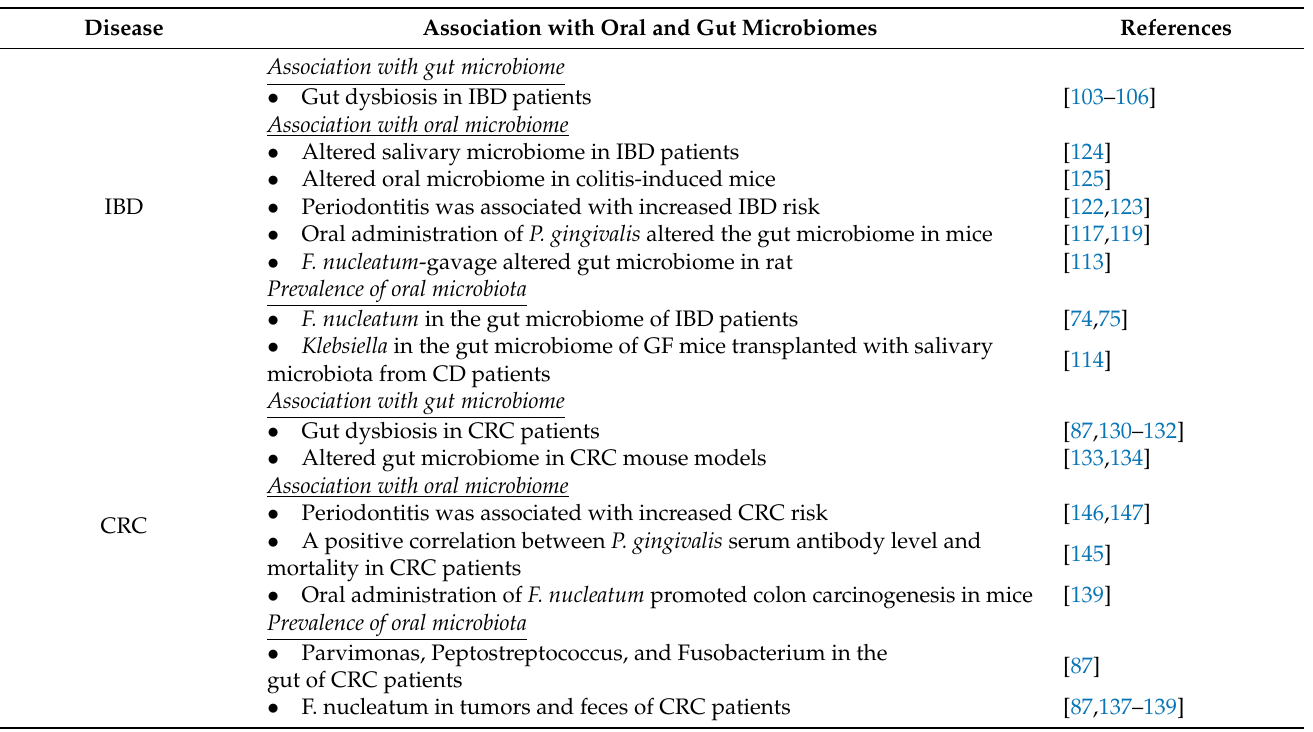
Table 1. Oral–gut microbiome axis in colon